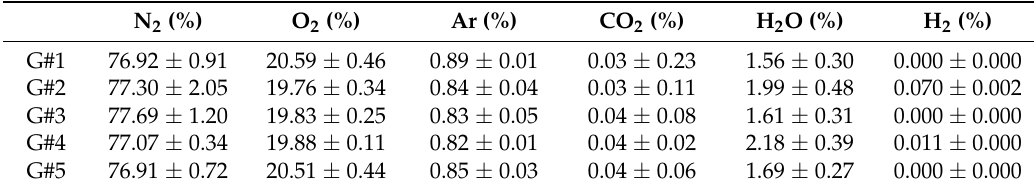
Table 2. Concentration of gases measured by RGA in the gaseous samples.